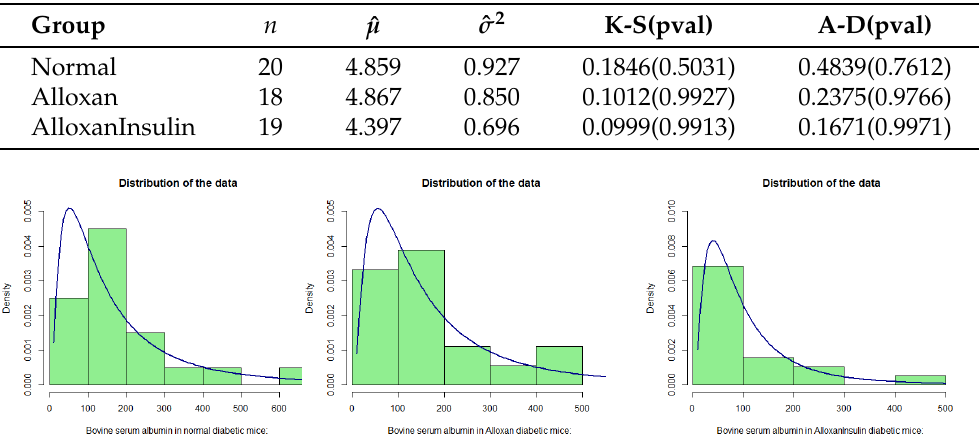
Table 8. Estimators of the log-normal distribution for the data of three groups.